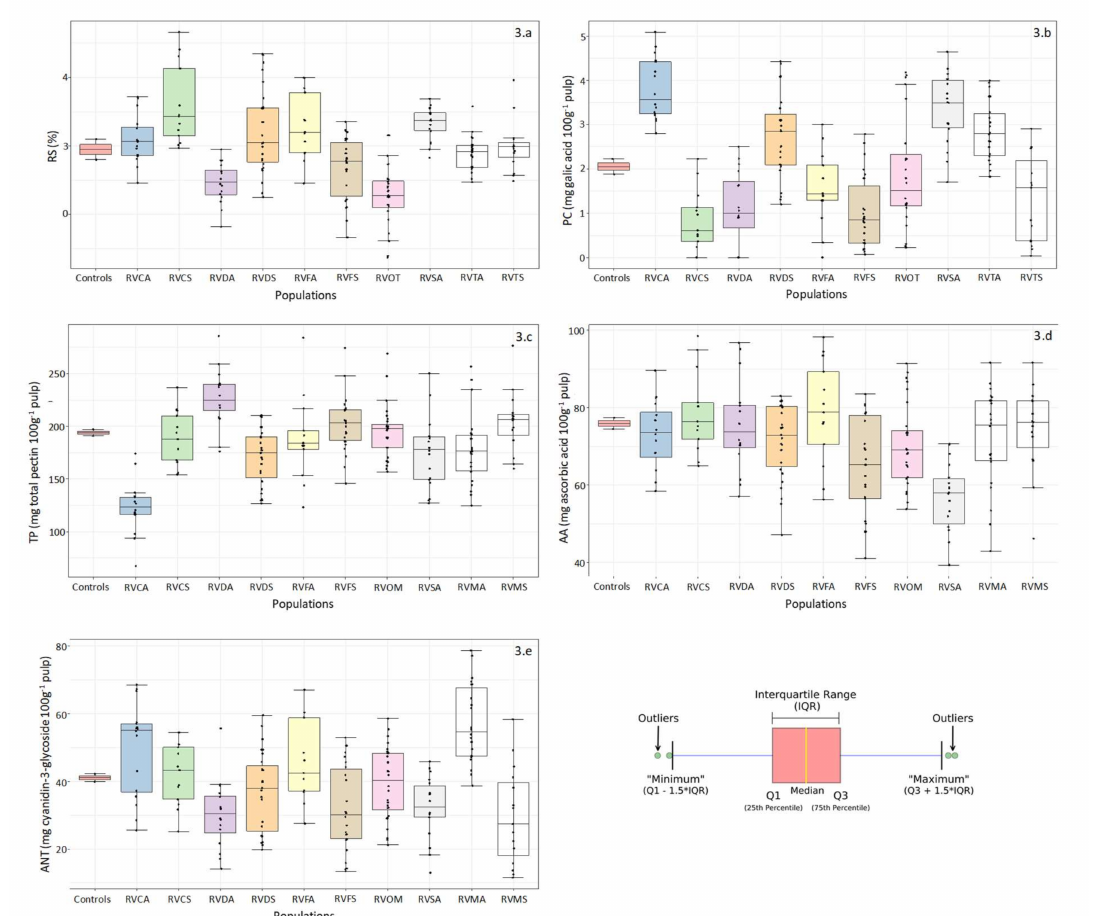
Figure 3. ( a ) Boxplot analysis for Reducing Sugar (RS, %), ( b ) Phenolic Compounds (PC, mg galic acid 100 g − 1 pulp), ( c ) Total Pectin (TP, g total pectin 100 g − 1 pulp), ( d ) Ascorbic Acid (AA, mg ascorbic acid 100 g − 1 pulp), and ( e ) Anthocyanins (ANT, mg pelargonidin-3-glycoside 100 g − 1 pulp)for genotypes of population